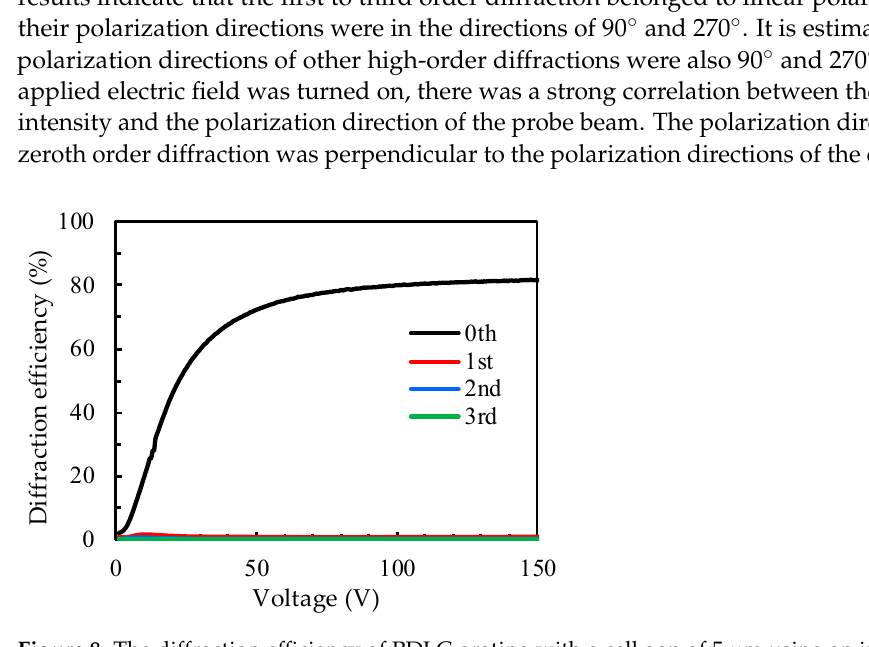
Figure 8. The diffraction efficiency of PDLC grating with a cell gap of 5 µ m using an incident beam of 0° polarization.